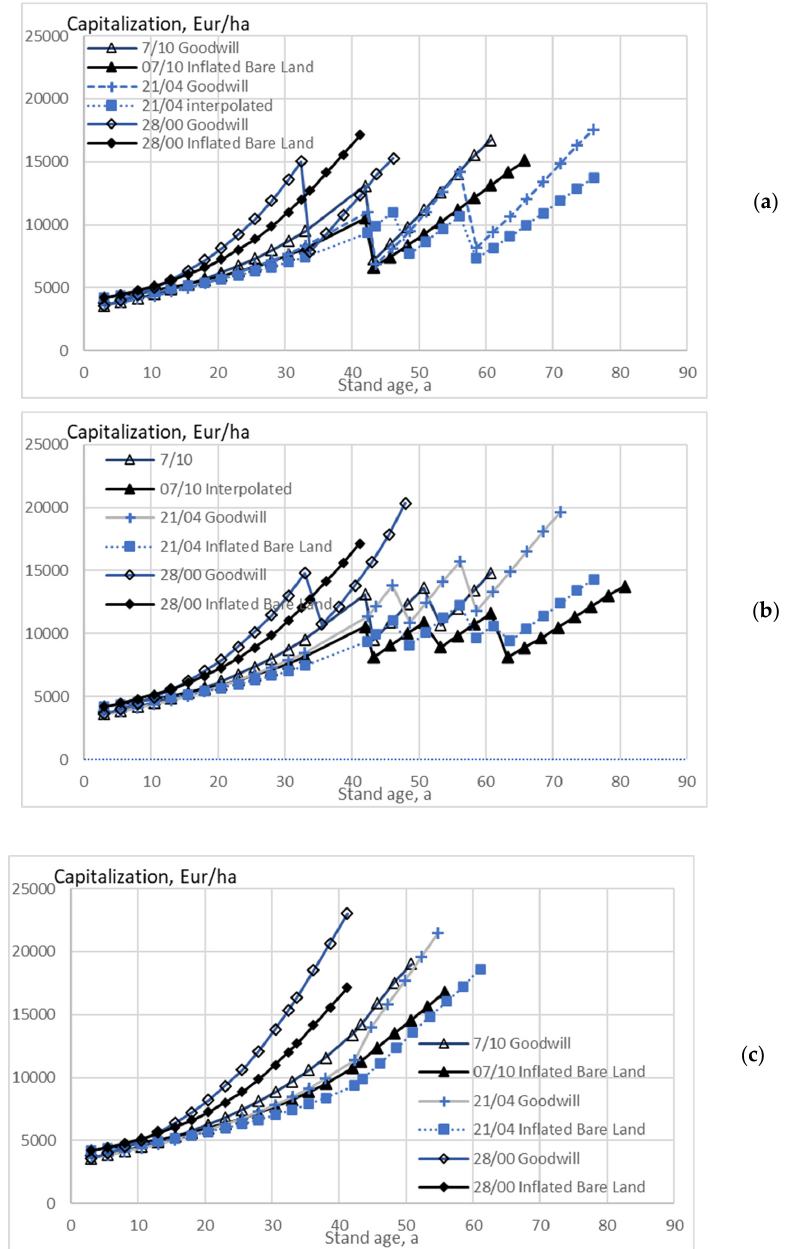
Figure 7. Stand capitalization as a function of stand age, when the growth model is applied to three observed wooded stands, without any thinning restriction ( a ), in good-quality trees of at least 238 mm of diameter only removed in thinning ( b ), and without any commercial thinning ( c ). Inflated capitalization is introduced either as proportional goodwill or as inflated bare land value; the numbers in legends identify stands and observation plots.